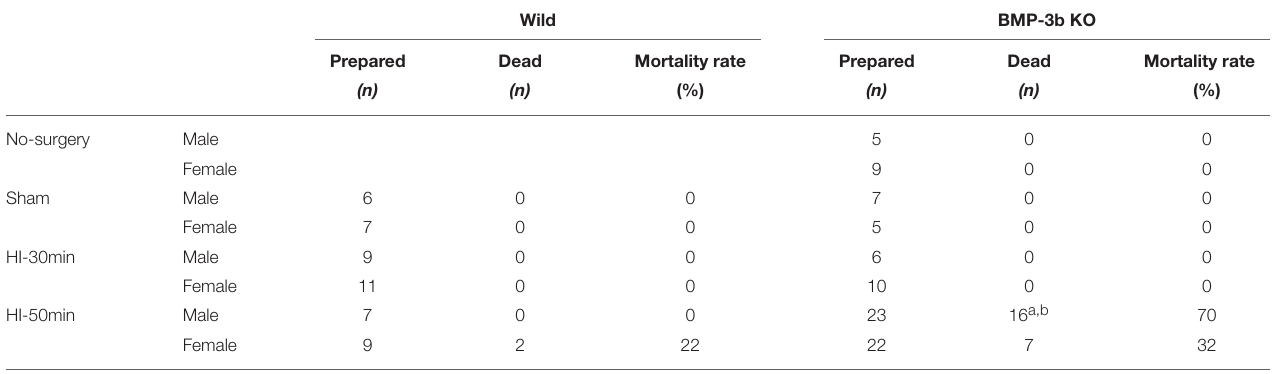
TABLE 1 | Numbers of animals prepared and mortality rates in each experimental group.